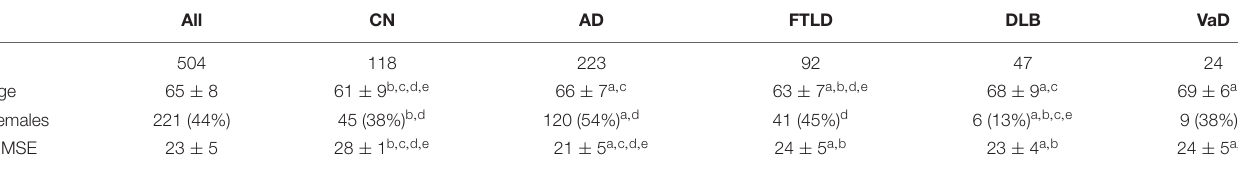
TABLE 1 | Basic characteristics of the patients in different diagnostic categories.